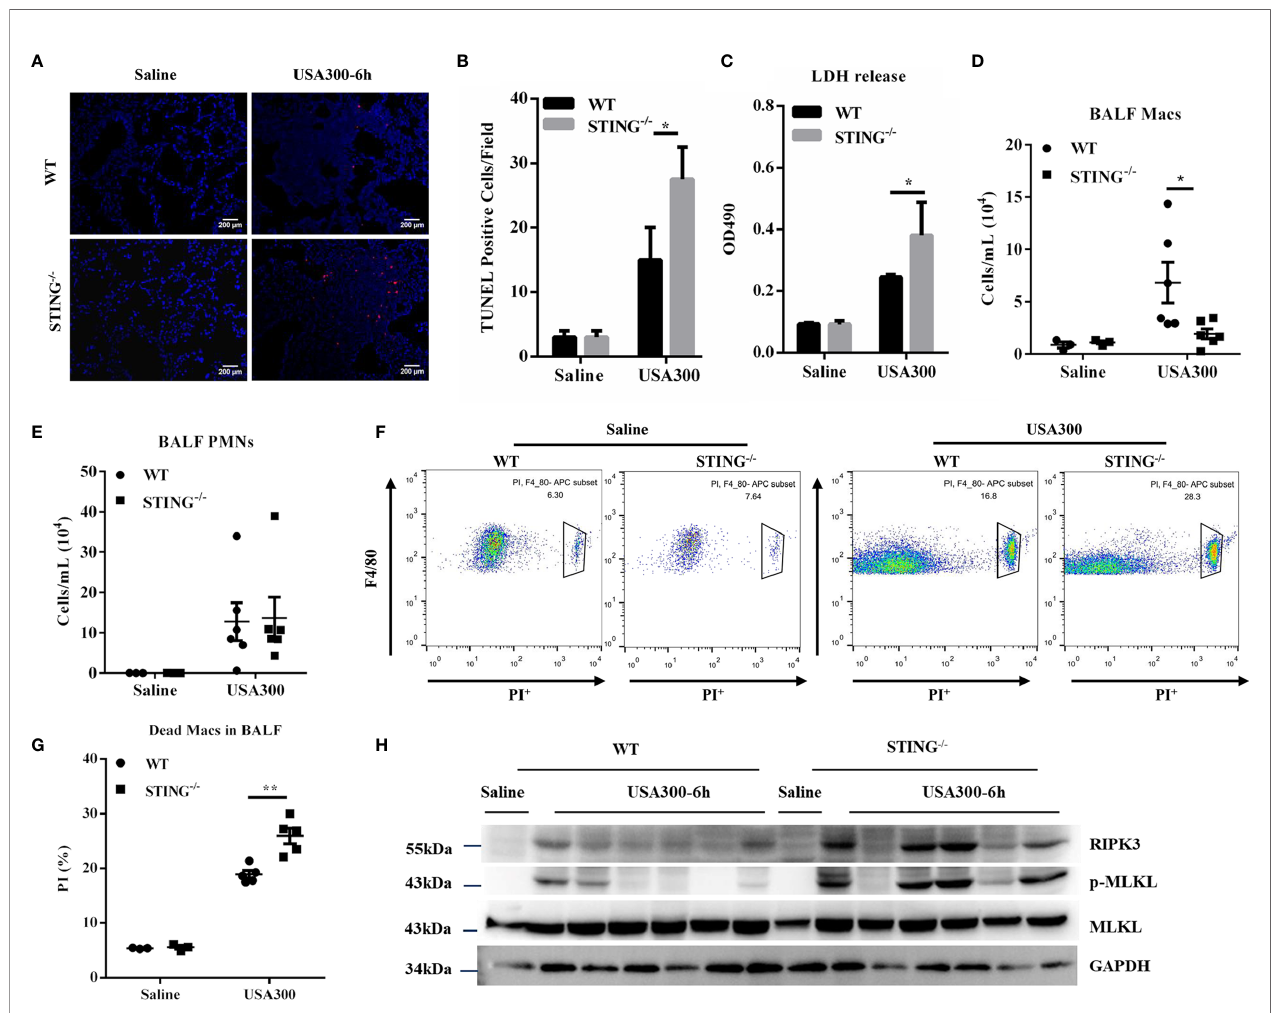
FIGURE 4 | STING -/- mice display increased necroptosis during early S.aureus induced pneumonia. WT and STING -/- mice were infected intranasally with S.aureus (1 × 10 8 CFU/mouse) and then were euthanized at 6 hpi. (A, B) TUNEL staining of dead cells in the lung tissues. (C) LDH released in BALF. (D, E) The numbers of neutrophils and macrophages in the BALF were enumerated. (F, G) Propidium iodide positive (PI + ) macrophages in the BALF were analyzed by fl ow cytometry. (H) The lung tissue lysate was analyzed for p-MLKL, MLKL, and RIPK3 by western blotting. GAPDH was used as a loading control. Student ’ s t-test was performed. Statistical signi fi cance is indicated by *p < 0.05 and **p <